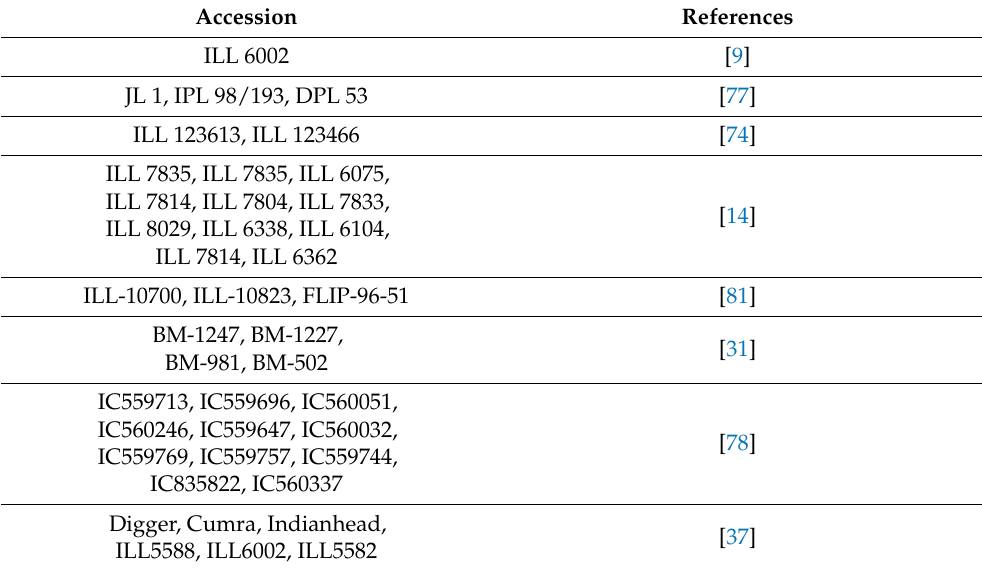
Table 1. Potential sources of drought tolerance identified in